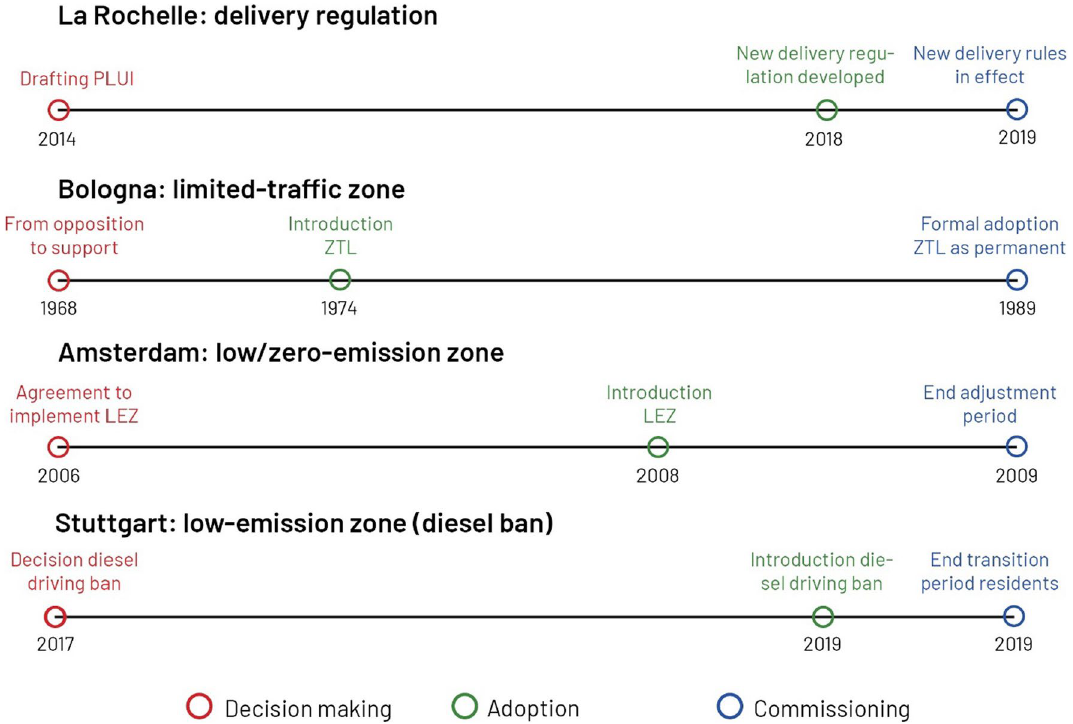
Fig. 8 Representation of case studies’ timeline and main events for the decision-making, adoption and commissioning gates (primarily regulatory